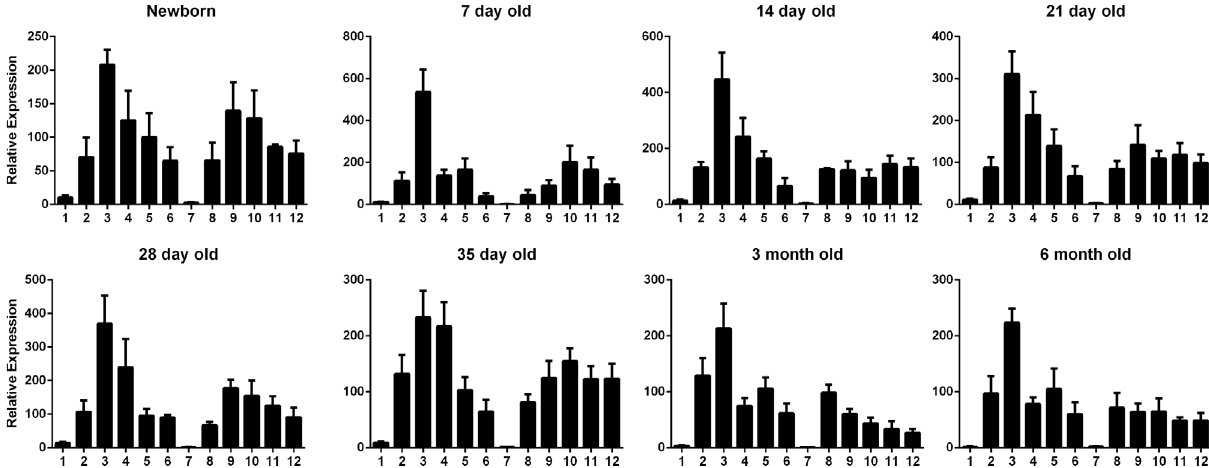
Figure 1 - Expression profile of MYD88 in tissues at different developmental stages, determined by the the 2 - (cid:5)(cid:5) Ct method. MYD88 expression in the mus- cle of the 3-month-old group was set at 1.0. 1, heart; 2, liver; 3, spleen; 4, lung; 5, kidney; 6, stomach; 7, muscle; 8, thymus; 9, lymph nodes; 10, duode- num; 11, jejunum; 12,